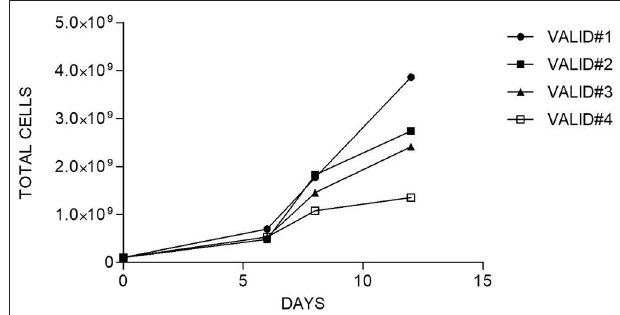
FIGURE 3 | Fold expansion of cells along the time in each manufacturing validation.